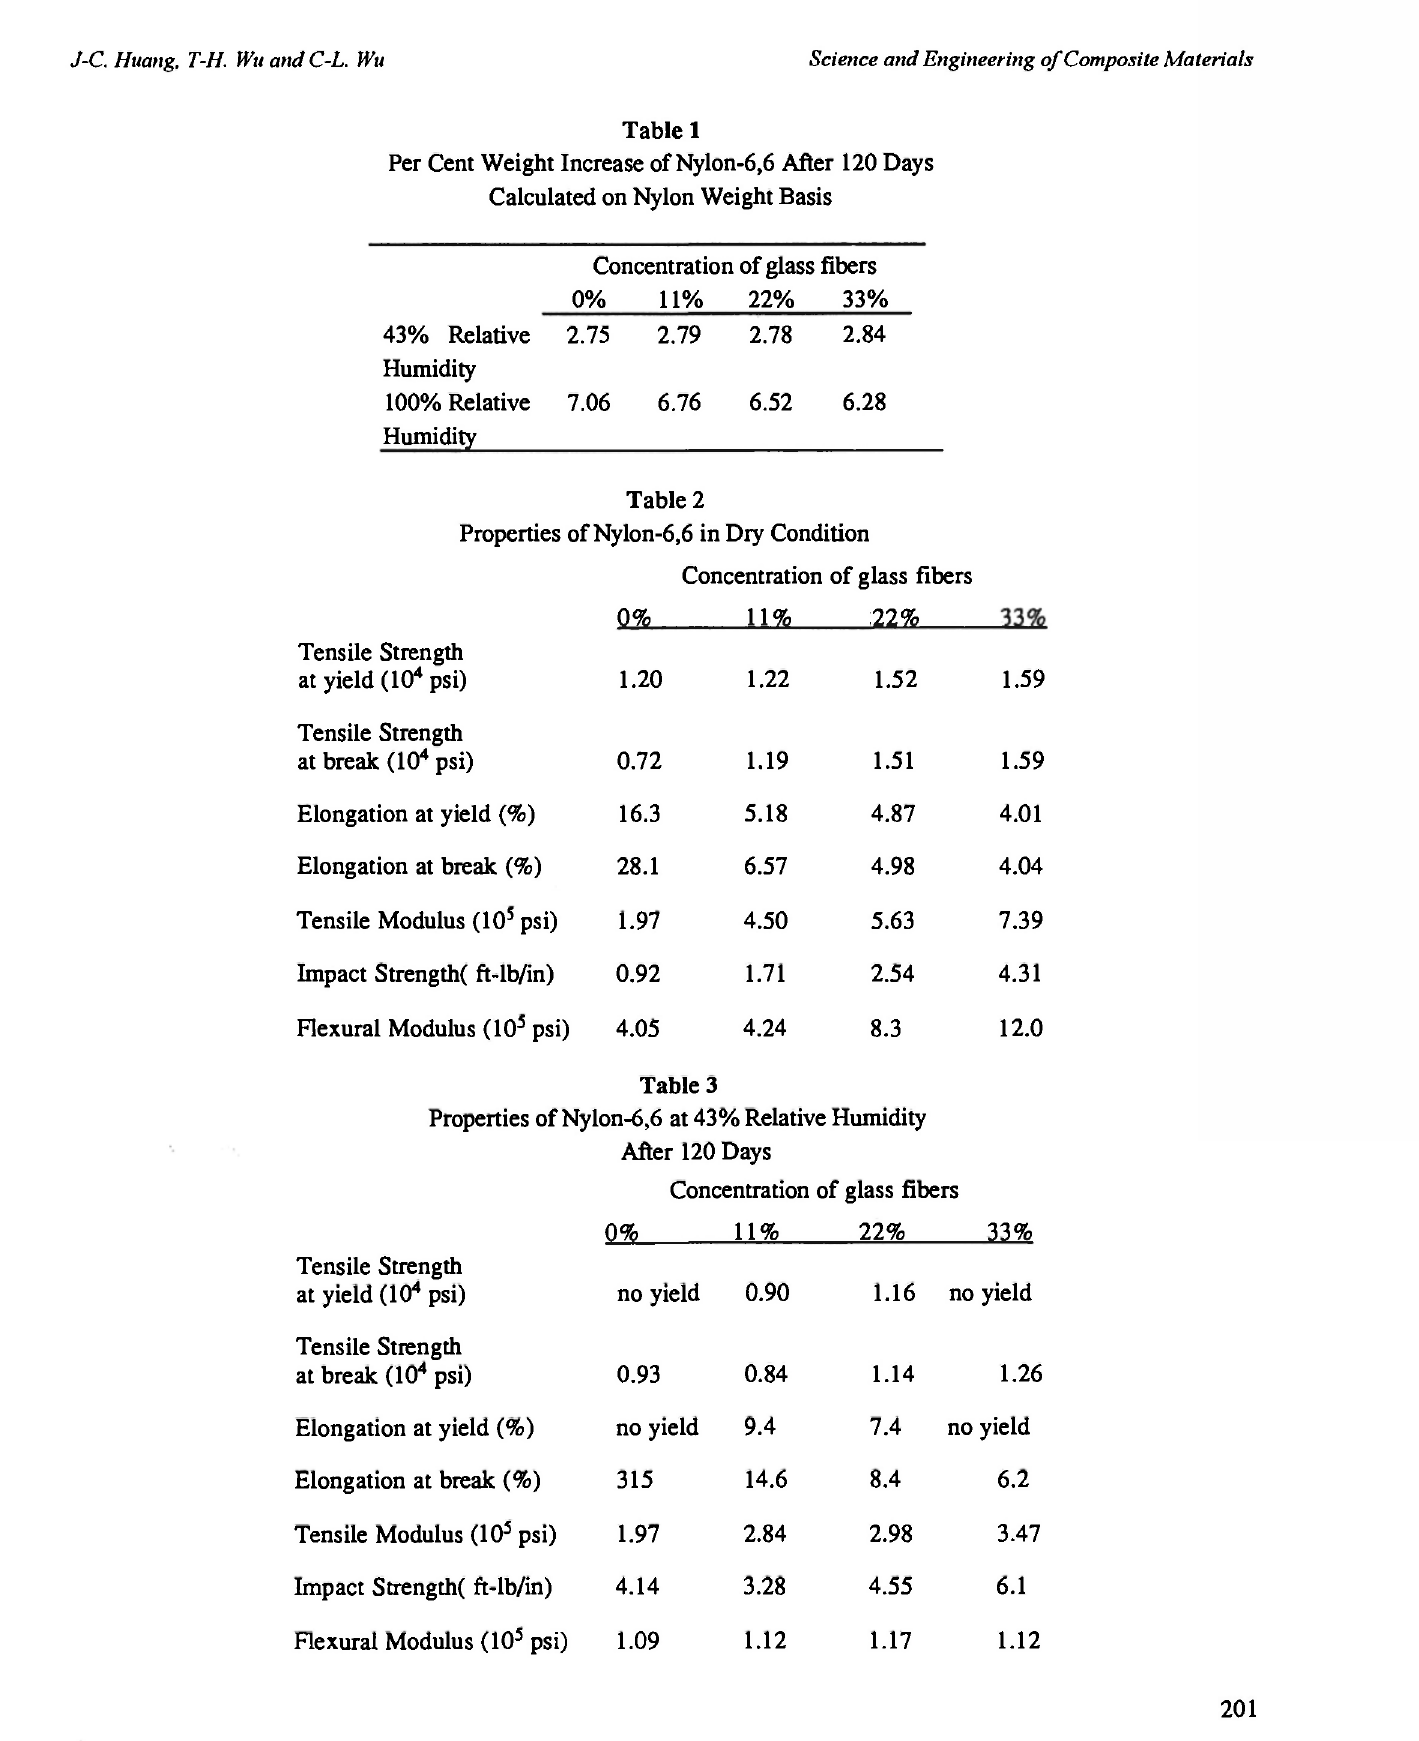
Per Cent Weight Increase of Nylon-6,6 After 120 Days Calculated on Nylon Weight Basis Concentration of glass fibers